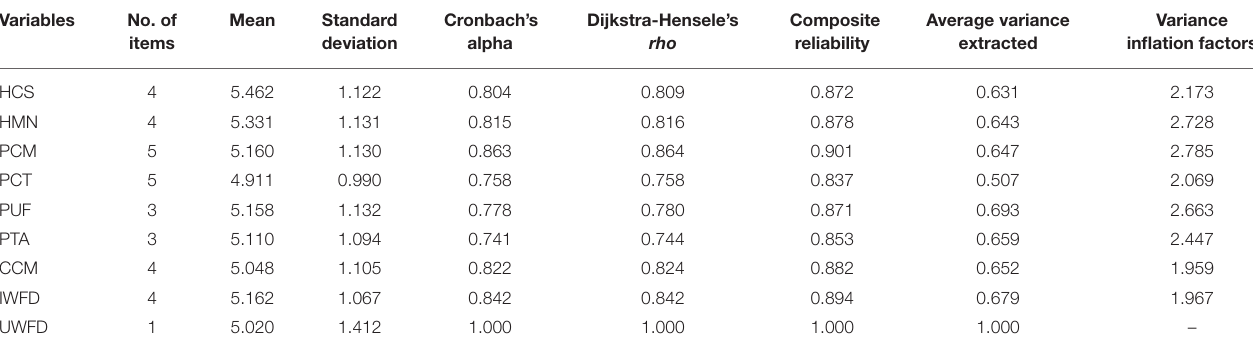
TABLE 2 | Reliability and validity.